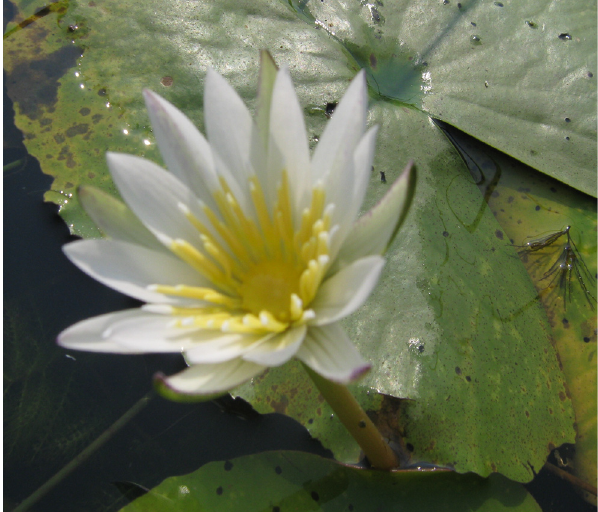
Fig. 17. Flowering twig of Nymphaea stellata F. Mueller